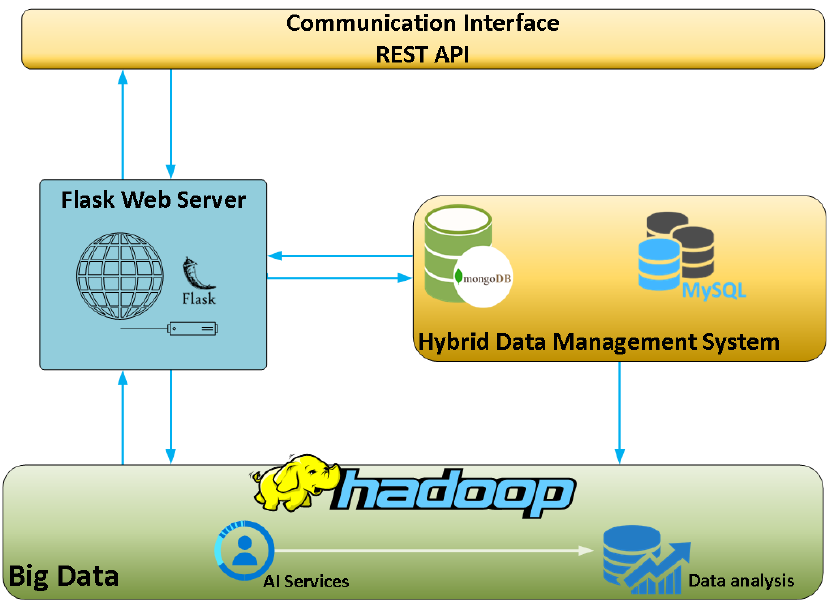
Figure 3. Layer two components of the DBDA platform.